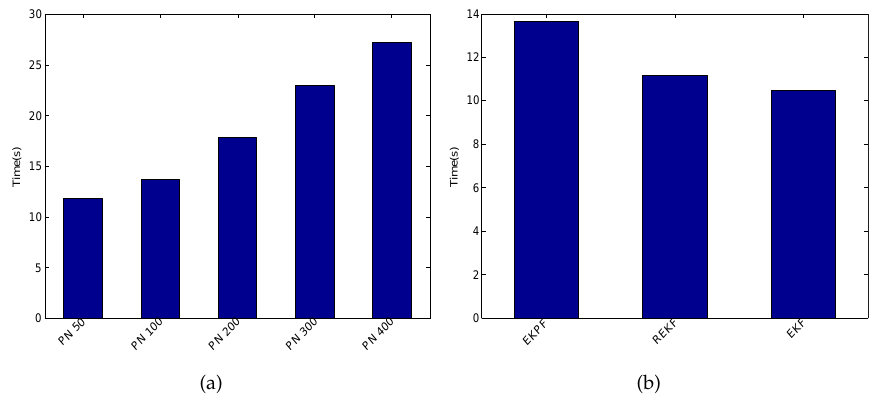
Figure 27. Comparison of computation time. ( a ) Under different number of particles; ( b ) Under different fusion